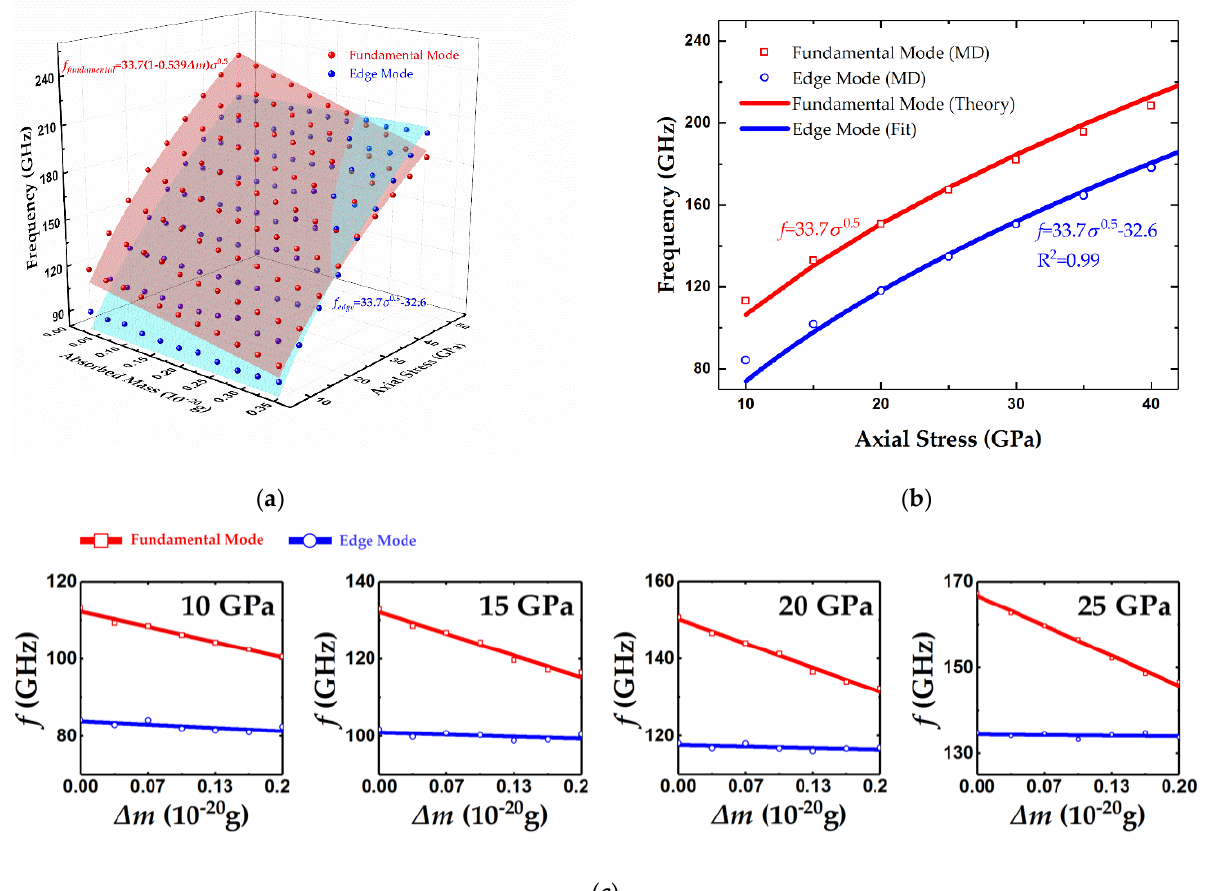
Figure 4. Resonant frequencies of fundamental and edge modes versus ( a ) centrally distributed absorbed mass and axial stress, ( b ) axial stress with no adsorbates, and ( c ) absorbed mass the axial stress in graphene sheet ranging from 10 to 25 GPa. Length and width of the doubly clamped graphene sheet are 100 and 50 Å, respectively.